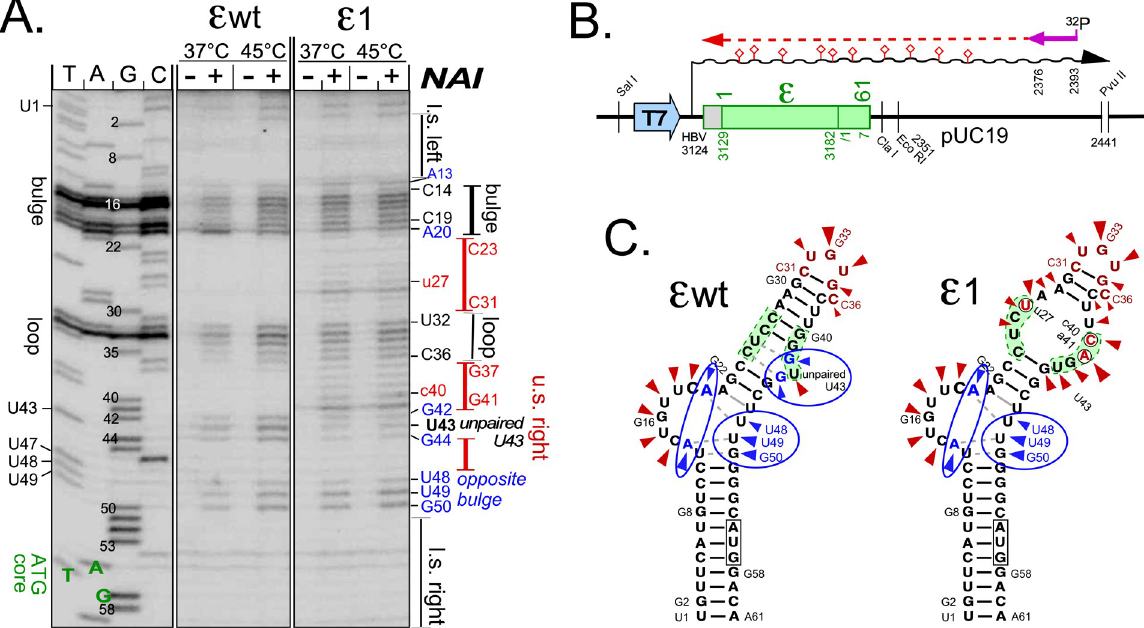
ε 1 mutations. (A) Analysis of SHAPE primer extension products by denaturing polyacrylamide gel electrophoresis (PAGE). RNAs produced as outlined in (B) were reacted with 2-methylnicotinic acid imidazolide (NAI) at 37˚C and 45˚C, and modified sites were mapped